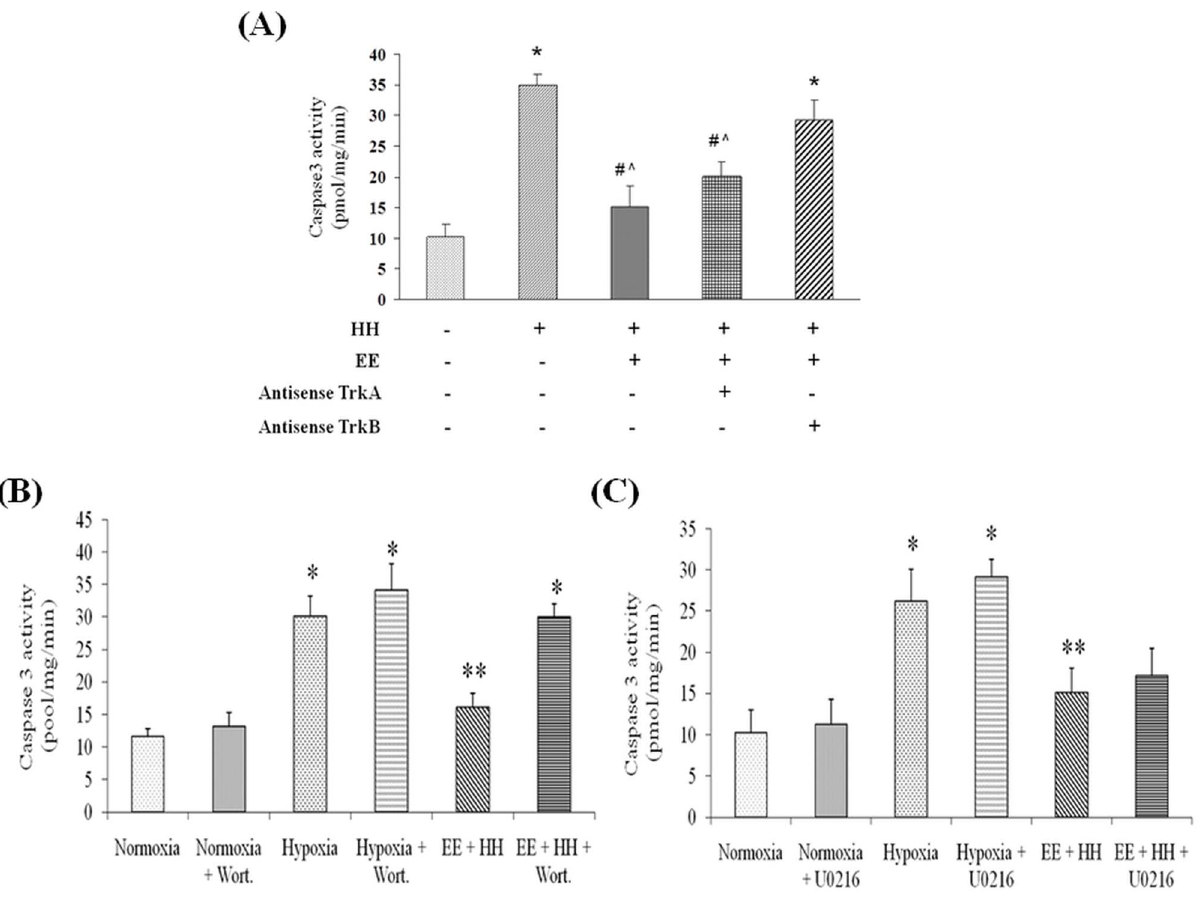
Figure 4. Role of neurotrophins was assessed using gene silencing technique for TrkA and TrkB receptors. Results showed that knockdown of TrkB significantly increased caspase3 activity even in presence of enriched environment whereas blocking of TrkA has diminutive effect on caspase3 activity in comparison to TrkB inhibition. To further explore the signaling cascade, ERK and PI3K pathway was blocked with U0216 and Wortmannin respectively and it has been observed that inhibition of PI3K pathway significantly increases caspase3 activity (B) whereas inhibiting ERK pathway have no significant effect in group exposed to hypobaric hypoxia in enriched cage (C). Data represents Mean 6 SEM. In ‘‘*’’ and ‘‘ # ’’ represents p , 0.001 when compared to control and hypoxic group while ‘‘ˆ’’represents p , 0.05 when compared to control group.